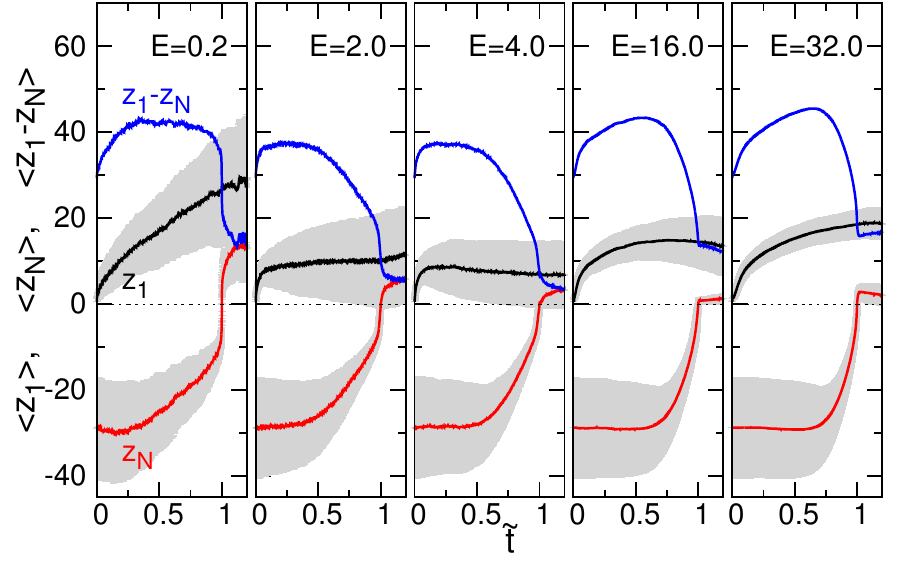
Figure 6. Averaged z-coordinates of chain end, (cid:104) z 1 (cid:105) and (cid:104) z N (cid:105) , and the difference (cid:104) z 1 − z N (cid:105) , as a function of ˜ t at different field strengths for N = 128. The gray region denotes the distribution range of a